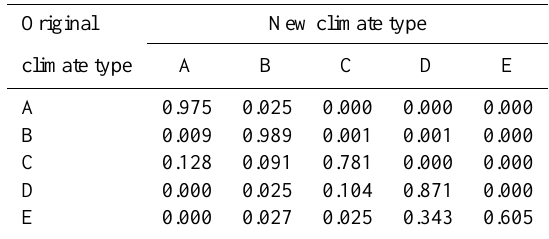
Table 4. Average fraction of changed major Köppen–Geiger cli- mate types between 2000 and 2099 based on five GCMs and four